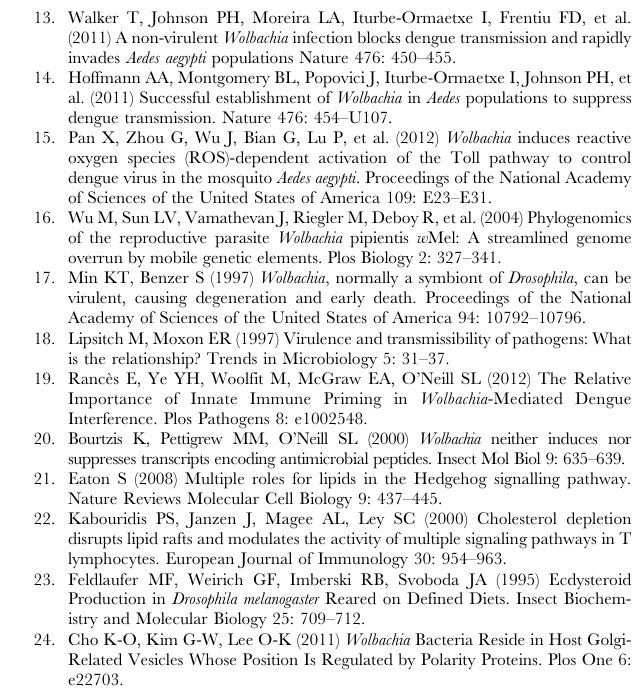
( H ), w MelCS experiments one ( I ) and three ( J ), and w Mel experiments one ( K ) and three ( L ). Figure S2 Survival curve after w MelPop-cured flies were challenged with DCV. Both Wolbachia -infected and – uninfected flies from all three dietary regimes were treated with tetracycline-hydrochloride for two generations to cure their Wolbachia infection. Upon challenge with DCV, there was no evidence of a pathogen blocking effect, with all lines showing complete mortality within seven days of infection. Figure key: Wolbachia -cured flies - dashed lines with rhomboid markers, uninfected flies – solid lines with square markers, PBS controls – dotted lines with circle markers, Standard diet – black line, Intermediate diet – red lines, High diet – blue lines. Table S1 ANOVA data for cholesterol quantification in each experiment. The ANOVA comparisons for the cholesterol quantification data from all 9 experiments. In the majority of experiments, ‘Infected’ is not a statistically significant variable, suggesting that host cholesterol levels are not affected by Wolbachia infection. ‘Diet’ is a significant factor for all experiments, suggesting that our cholesterol-enriched diets were a critical factor affecting host cholesterol